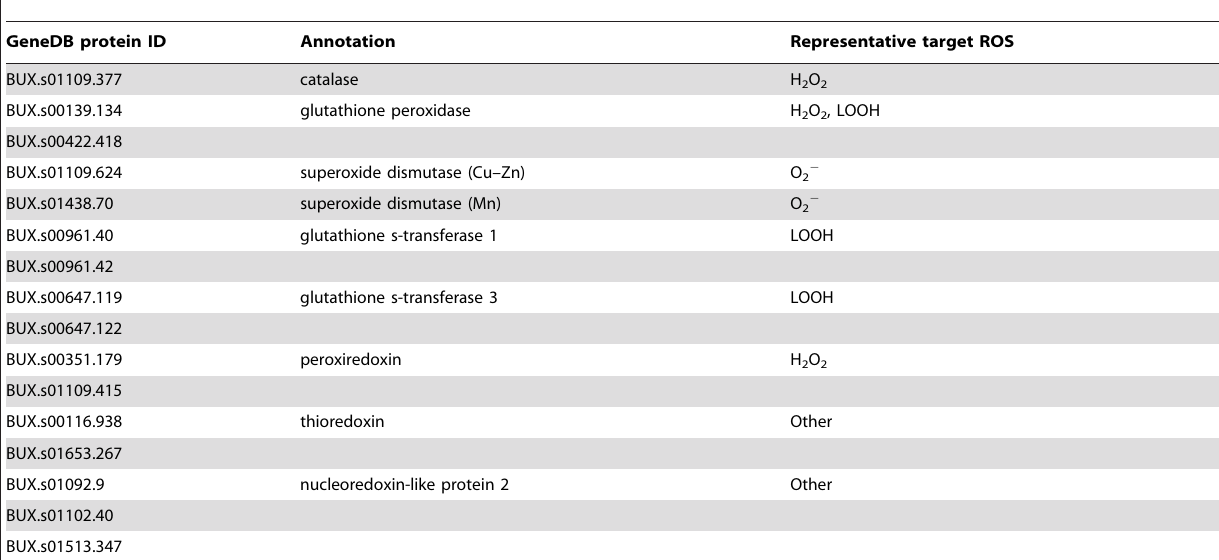
Table 4. Anti-oxidant and detoxifying enzyme proteins that are secreted from Bursaphelenchus xylophilus .